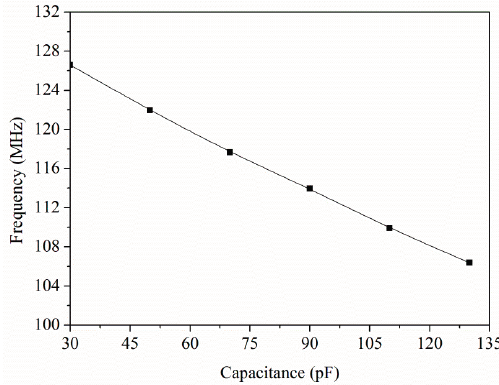
Figure 3. Simulated results of the output frequency for the circuit.